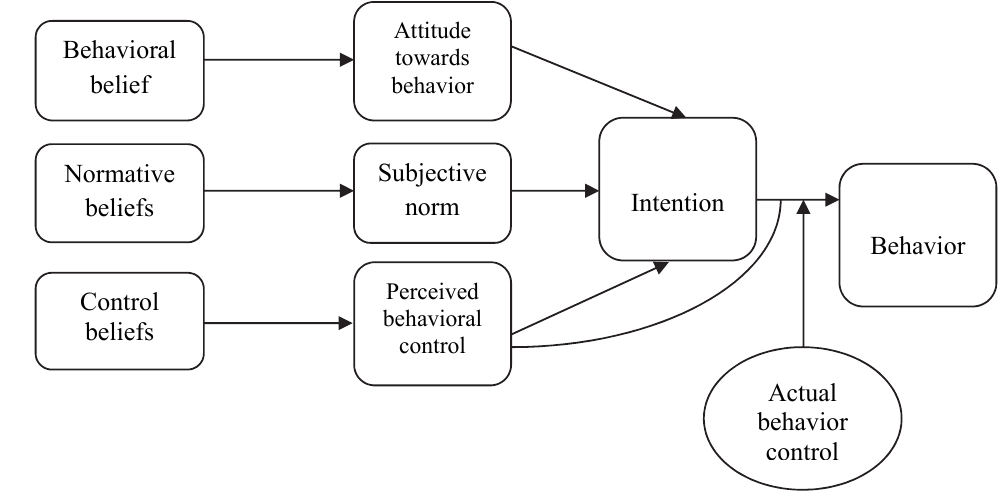
Fig. 1. Theory of Planned Behavior (Ajzen,